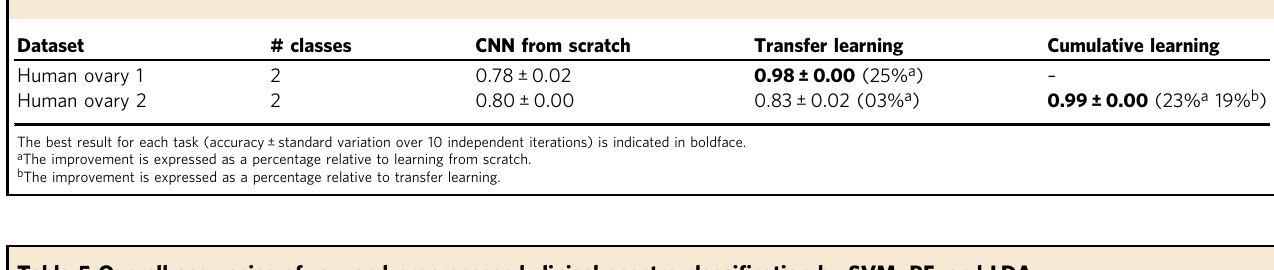
Table 5 Overall accuracies of raw and preprocessed clinical spectra classi fi cation by SVM, RF, and LDA. Datasets